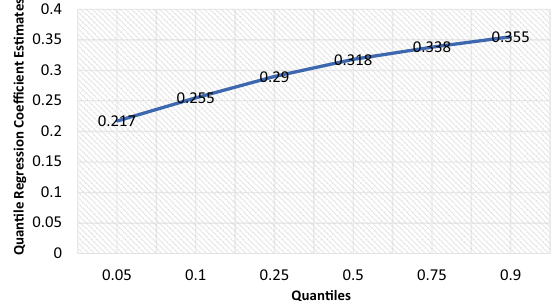
Fig. 9 Plot of coefficients of quantile regression for MIL and RGDP nexus